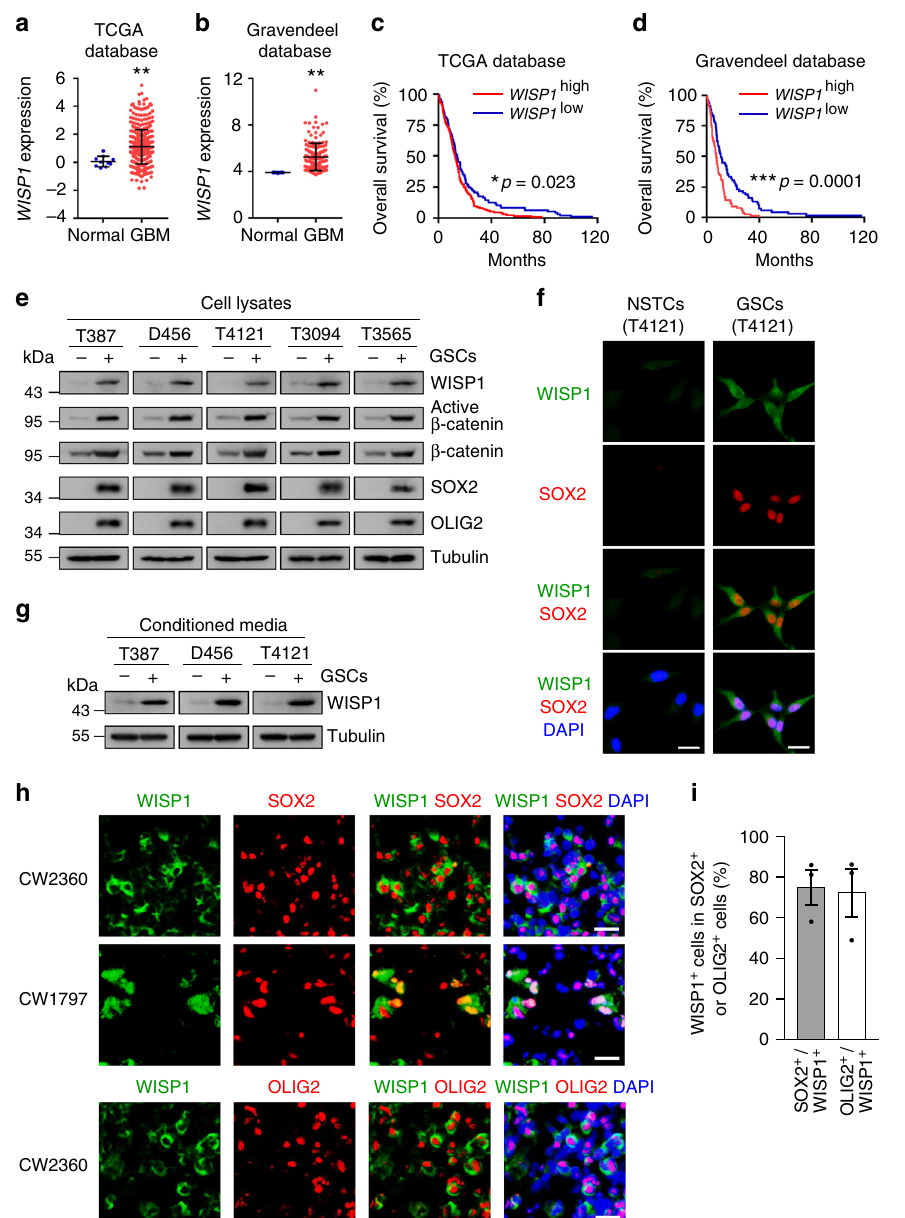
Fig. 1 WISP1 predicts poor prognosis for GBM patients and is preferentially secreted by GSCs. a WISP1 expression in human normal brain tissues and GBM tumor samples from the TCGA database. Normal, n = 10; GBM, n = 488. Data are shown as means ± s.d. ** p = 0.0077, two-tailed unpaired t -test. b WISP1 expression in human normal brain tissues and GBM samples from the Gravendeel database. Normal, n = 8; GBM, n = 159. Data are shown as means ± s.d. ** p = 0.0017, two-tailed unpaired t -test. c Kaplan – Meier survival analysis of WISP1 expression and the overall survival of GBM patients from the TCGA database. WISP1 high, n = 157; WISP1 low, n = 122. * p = 0.023, log-rank test. d Kaplan – Meier survival analysis of WISP1 expression and the overall survival of GBM patients from the Gravendeel database. WISP1 high, n = 80; WISP1 low, n = 79. *** p = 0.0001, log-rank test. e Immunoblot analyses of WISP1, active β -catenin, total β -catenin, SOX2, and OLIG2 expression in cell lysates of GSCs ( + ) and matched non-stem tumor cells (NSTCs) ( – ). f Immuno fl uorescent staining of WISP1 (green) and SOX2 (red) in T4121 GSCs and matched NSTCs. Scale Bar, 20 μ M. g Immunoblot analysis of WISP1 expression in conditioned media from GSCs ( + ) and matched NSTCs ( – ). GSCs and matched NSTCs were cultured in neurobasal media without supplements for 40 h and the media was concentrated by vacuum centrifugation. Tubulin in corresponding cell lysates was used as a loading control. h Immuno fl uorescent staining of WISP1 (green) and the GSC marker SOX2 or OLIG2 (red) in human primary GBMs. WISP1 was preferentially expressed in GSCs and distributed in the area near GSCs. Scale Bar, 20 μ M. i Graphical analysis of ( h ) showing the fraction of WISP1 + cells in SOX2 + or OLIG2 + cells in human primary GBMs. More than 70% of SOX2 + or OLIG2 + GSCs showed WISP1 staining. n = 3 independent GBMs. Data are represented as means ± s.e. m. Source data are provided as a Source data fi